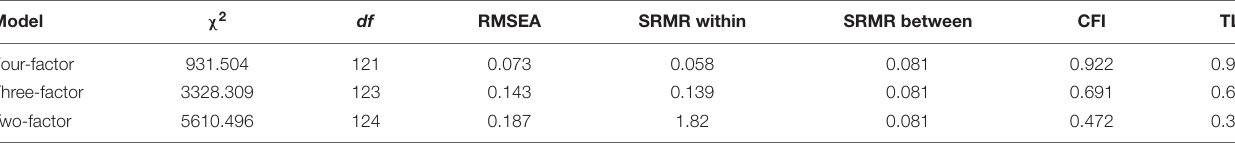
TABLE 2 | Multilevel confirmatory factor analysis.